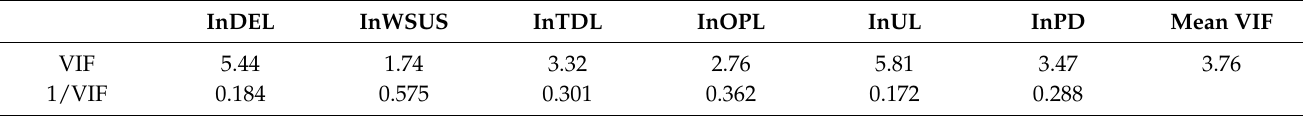
Table 4. The VIF